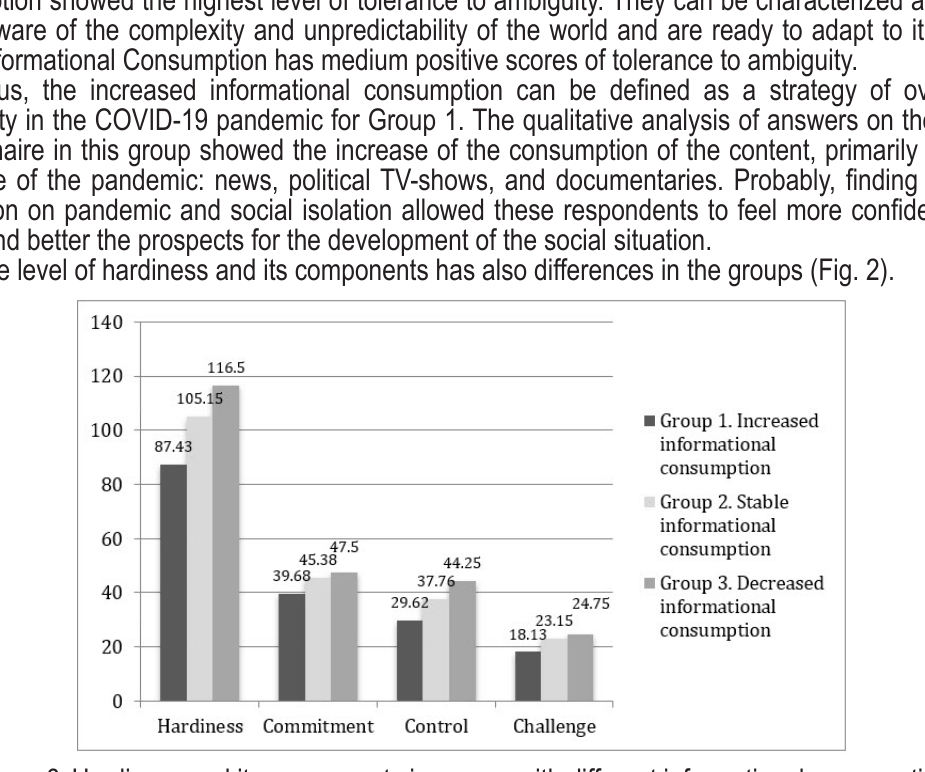
Figure 2. Hardiness and its components in groups with different informational consumption The average score in hardiness and its components (commitment, control, challenge) for the Group 1 Increased Informational Consumption is also lowest for the sample, but can be rated as standard showed the highest level of hardiness, commitment, control and